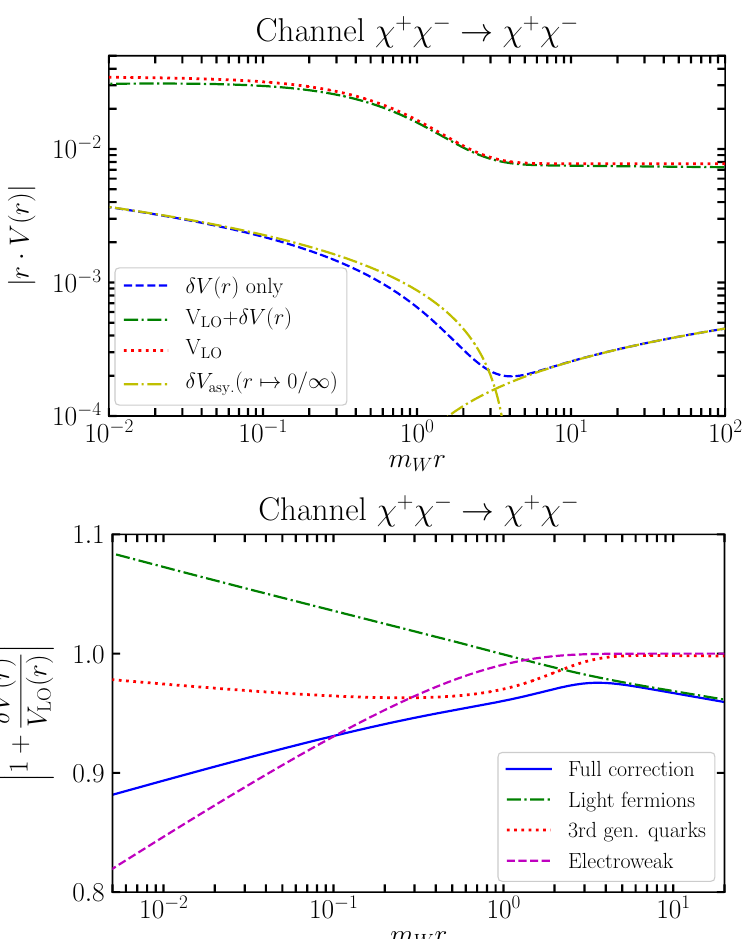
Figure 2 . The NLO correction to the potential in the channel χ + χ − → χ + χ − . The upper panel shows the modulus of the potential | r · V ( r ) | for the LO and NLO potential, the NLO contribution only, and the small and large-distance asymptotic behaviour. In the lower panel, we show the ratio of the full NLO potential to the LO potential (blue solid), and separately for the three gauge-invariant pieces identified in the text (other